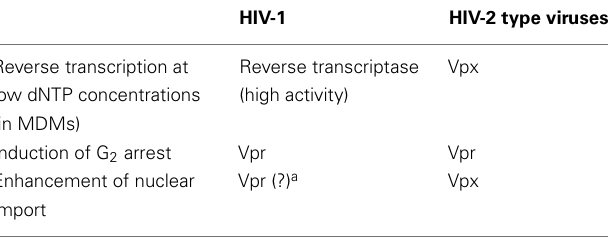
Table 1 |The roles ofVpx andVpr in HIV-1 and HIV-2-type